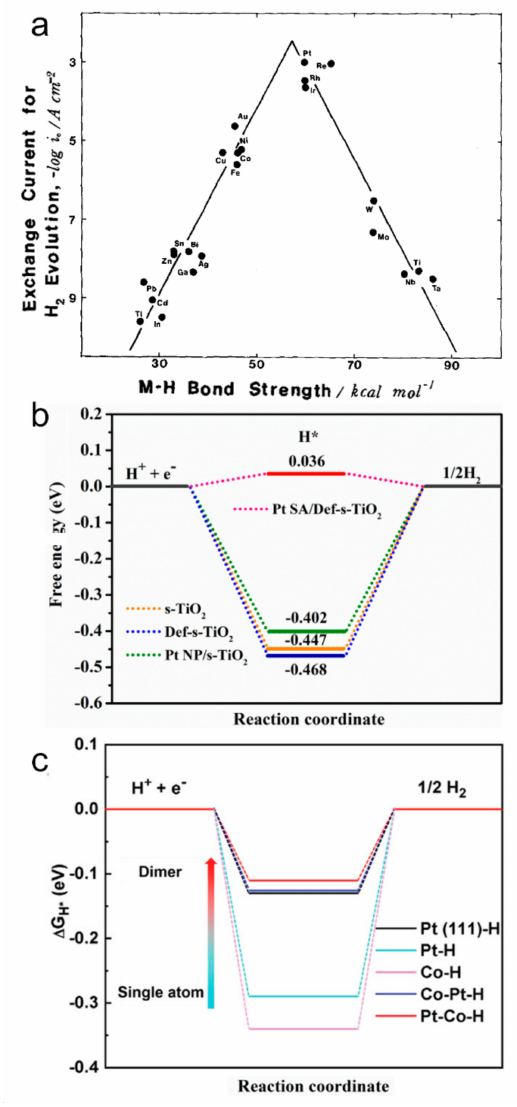
Figure 3. ( a ) Exchange currents for electrolytic hydrogen evolution vs. strength of intermediate metal-hydrogen bond formed during electrochemical reaction itself. Adapted with permission from Ref. [84]. ( b ) DFT calculations of free energy ∆ G H* for H adsorption on s-TiO 2 , Def-s-TiO 2 , Pt SA/Def- s-TiO 2 , and Pt NP/s-TiO 2 surface. Adapted with permission from Ref. [89]. ( c ) Gibbs free energy of H adsorption on Co single-atom, Pt single-atom, Co–O–Pt dimer, and bulk Pt (111) sites. Adapted with permission from Ref.